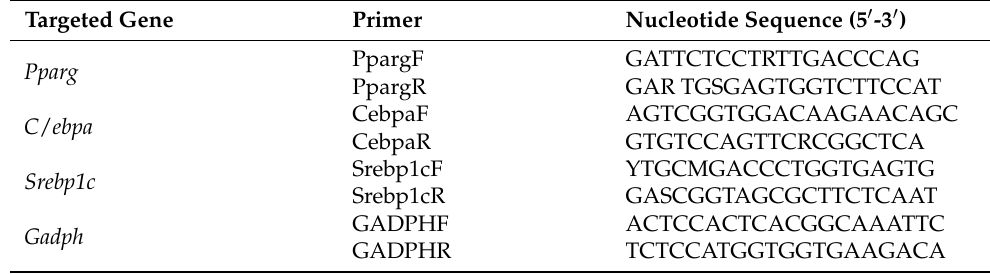
Table 1. RT-qPCR primers used in this